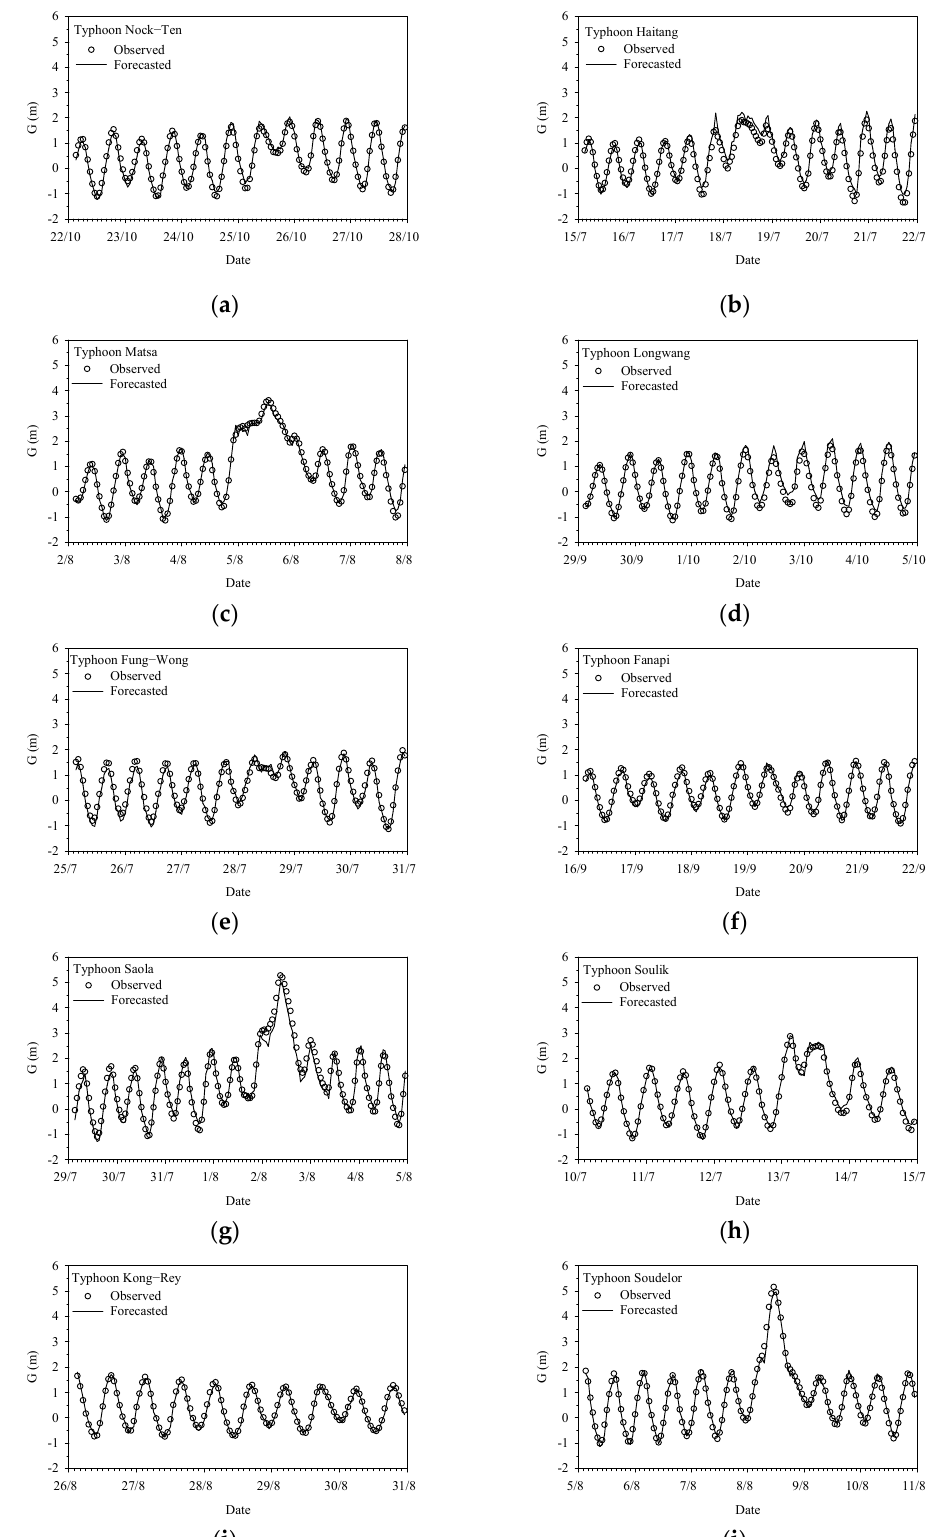
Figure 9. Comparison between 1 h ahead forecasted water levels and observed water levels during typhoons for calibration phase: ( a ) Typhoon Nock−Ten; ( b ) Typhoon Nock−Ten; ( c ) Typhoon Matsa; ( d ) Typhoon Longwang; ( e ) Typhoon Fung−Wang; ( f ) Typhoon Fannapi; ( g ) Typhoon Saola; ( h ) Typhoon Soulik; ( i ) Typhoon Kong−Rey; ( j ) Typhoon Soudelor.